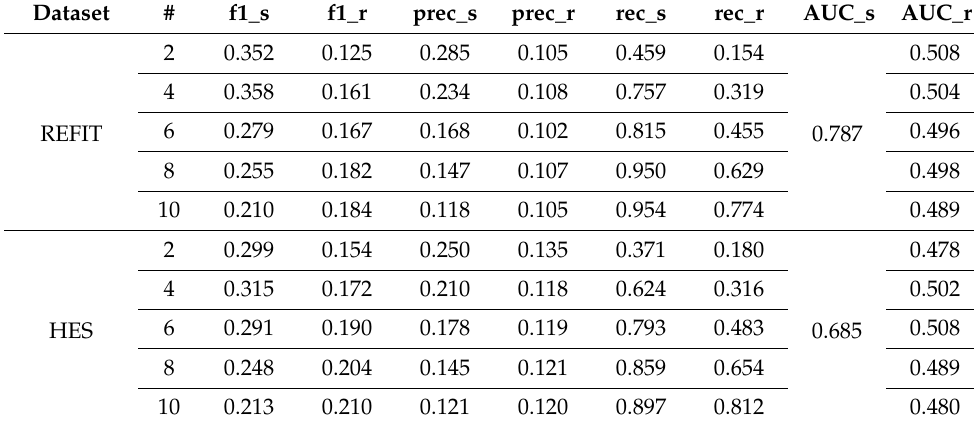
Table 4. Seven day-single appliance (tumble